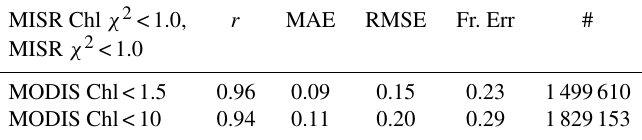
Table 2. Statistics of MISR vs. MODIS regional chlorophyll a retrievals. In this table, r is the Pearson correlation coefficient, MAE is the median absolute error, RMSE is the root-mean-square error between MISR and MODIS–Terra, Fr. Err is the mean absolute fractional error of the MISR RA retrieval with respect to MODIS–Terra, and # is the number of validation cases included. MISR Chl χ 2 <1.0,